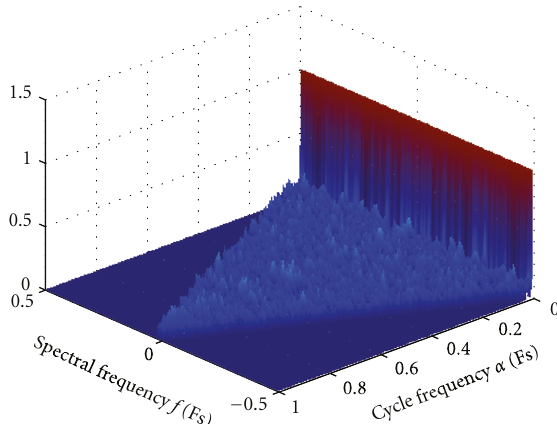
Figure 7: SOF of an OFDM signal in an AWGN Channel at low (0dB) SNR, with 32 subcarriers, subcarrier spacing Δ F = Fs/10, Fc = 0.25 Fs, no. of samples =